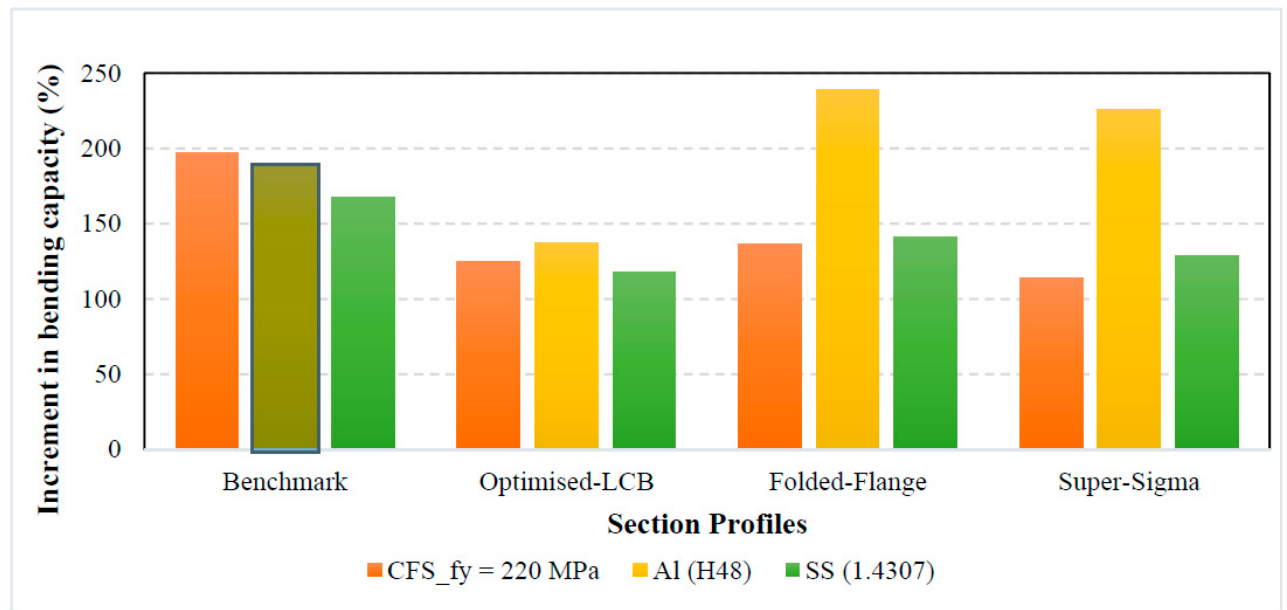
Figure 15. Bending capacity increment comparison for similar strength of different materials.